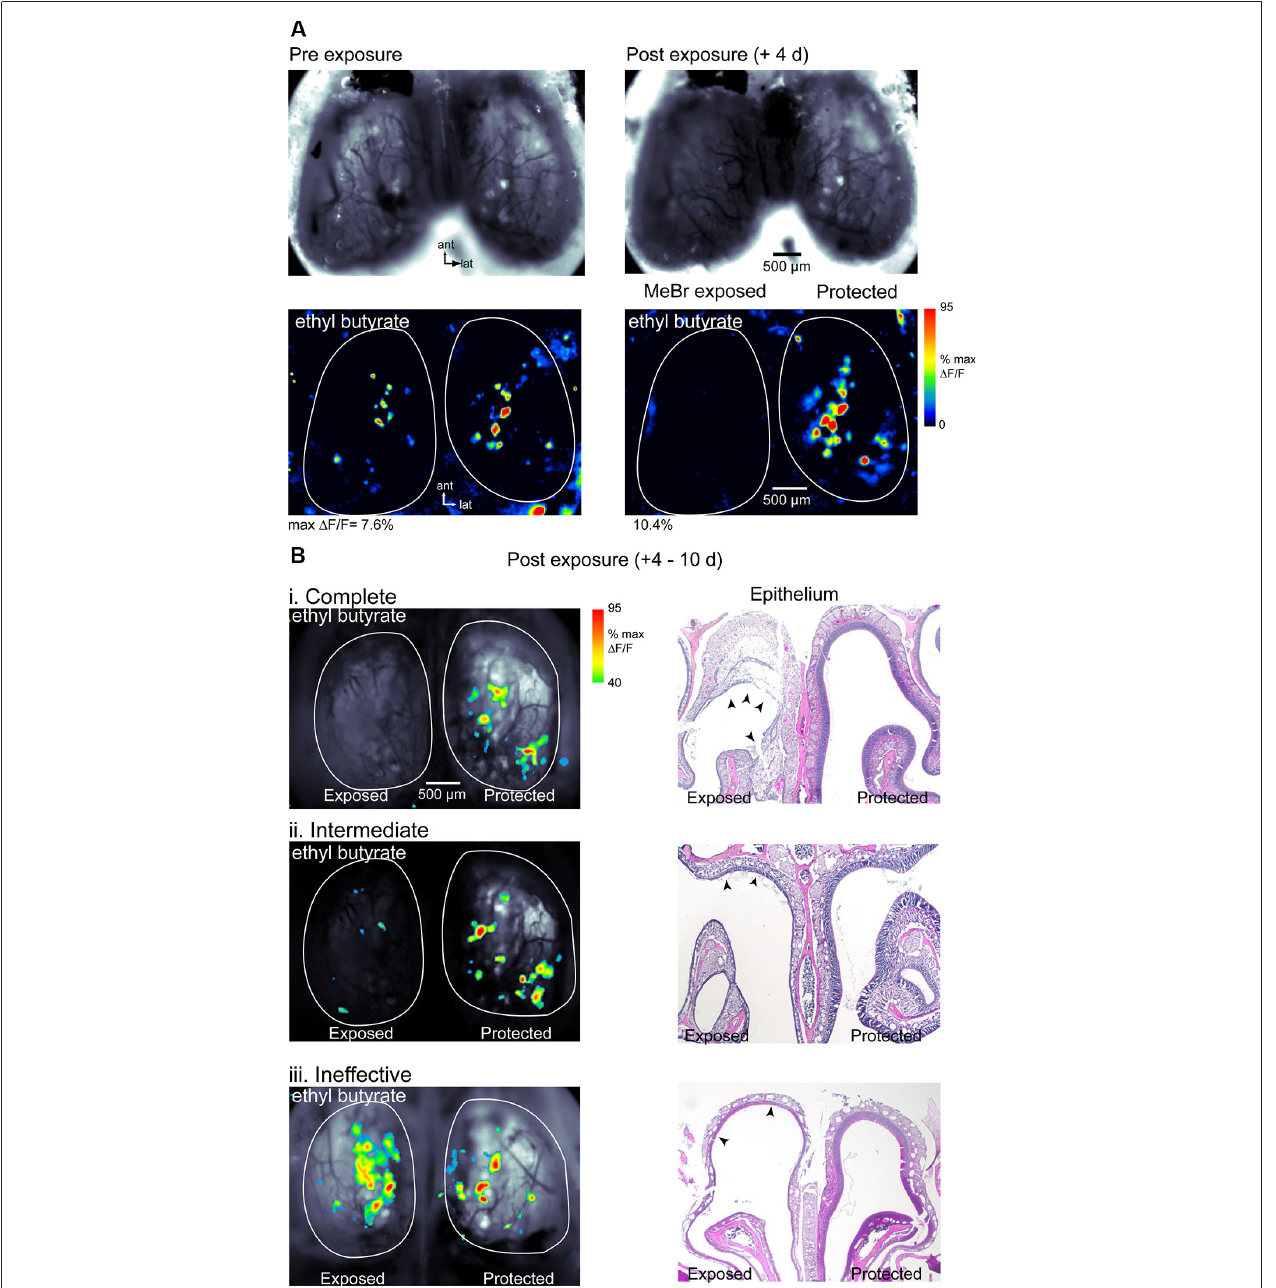
The nasal cavity showed widespread damage to the OE in all three animals. In the complete lesion (i) , the full tangential extent of the dorsomedial epithelium has been lesioned and in many areas the damage extends through the basal lamina ( arrowheads ), leading to an exudation that will become organized as endonasal scar tissue (cf. asterisks in Figure 8B ). In the intermediate lesion (ii) , the full tangential extent of the dorsomedial epithelium is damaged but there are some residual neurons along the roof of the dorsal meatus ( arrowheads ). In the “ineffective” lesion (iii) , the full tangential extent of the dorsomedial epithelium is also damaged but there are residual neurons along the roof of the meatus in the area between the two arrowheads . Resting spH fluorescence in the OB is sharply diminished in the “complete” and “intermediate” lesions, but appears normal in the “ineffective”